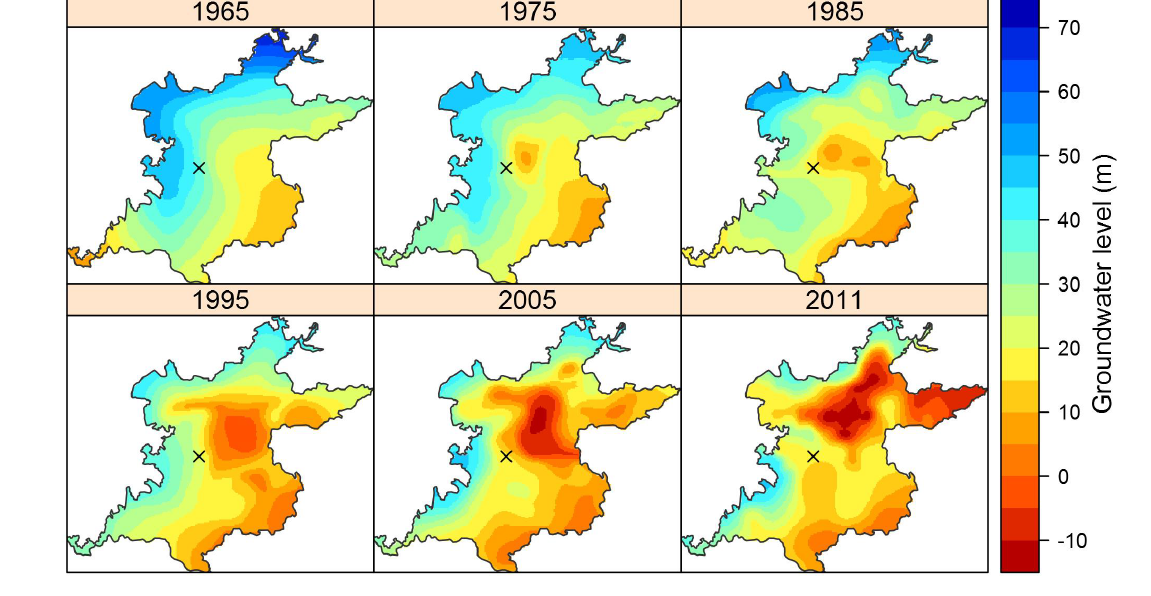
Fig. 6 . Maps of groundwater level for the plain area of Beijing (mountainous area in the west is not shown) in 1965, 1975, 1985, 1995, 2005, and 2011. “X” denotes the core urban area. Data from Zhang et al. (2008) and Beijing Water Resource Bulletin